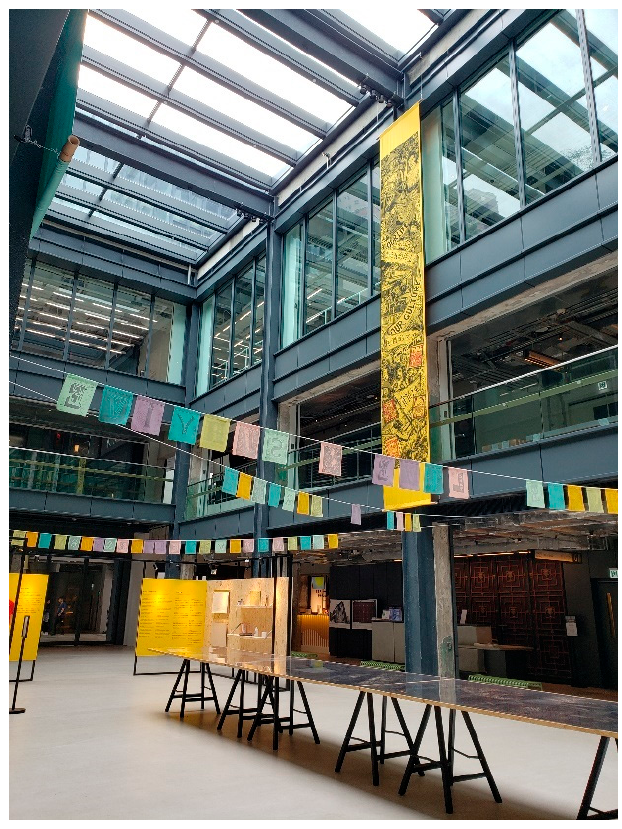
Figure 4. Lots of glass walls installed for more natural sunlight.